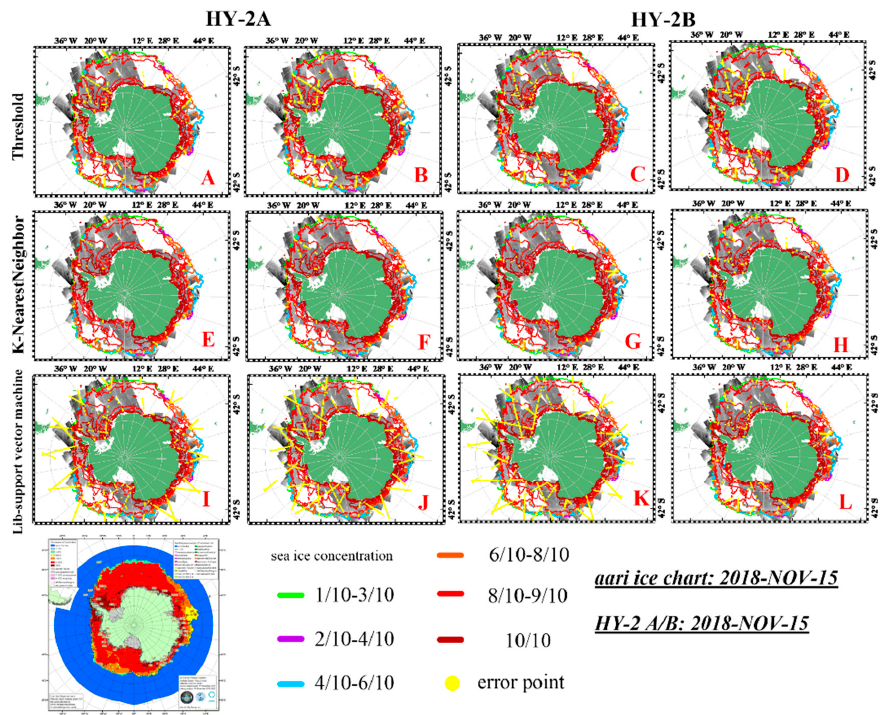
Figure 19. Distributions of the classification errors of the three methods in the Antarctic region: Figure 19A,E,I and C, G, K indicate the C Band results of the HY-2A / B, respectively; Figure 19B,F,J and D, H, L indicate the Ku Band results of the HY-2A / B, respectively. Note: The color boundaries of the different types ice in the Figure 19A-L are consistent with the classifications in the ice chart.